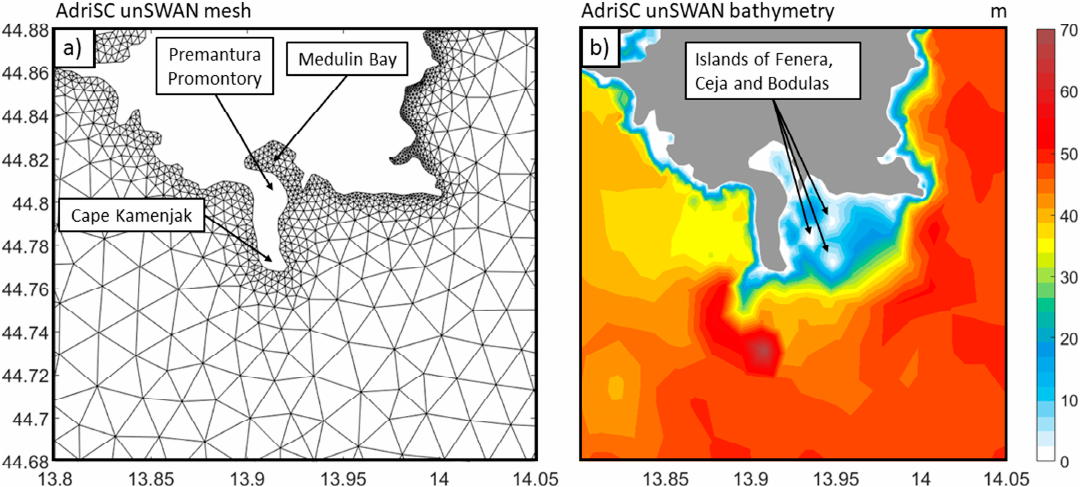
Figure 9. AdriSC unSWAN mesh structure (panel a ) and bathymetry (panel b ) in the vicinity of the Premantura area. Premantura